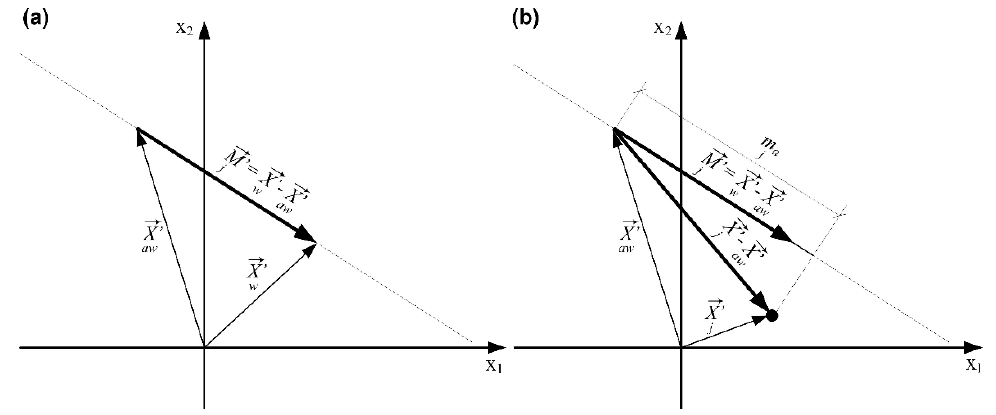
Figure 5. Measure values dependent on object location: ( a ) measurement vector m . measure a j